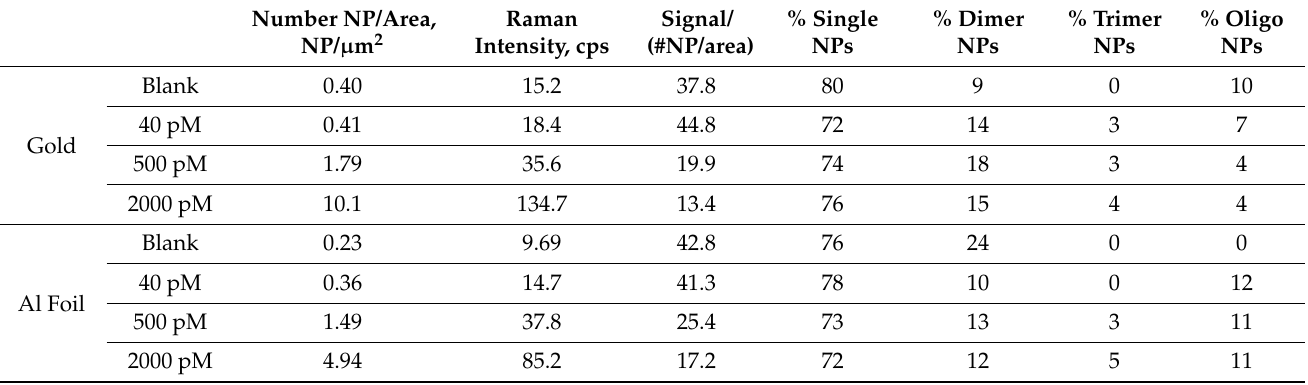
Table 1. Results of SEM characterization of hIgG assay on gold film and Al